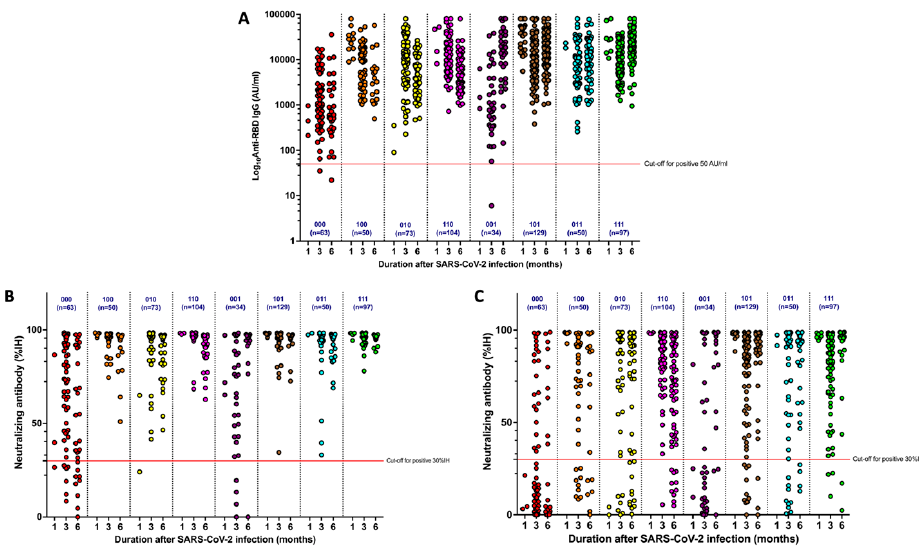
Figure 3. Dynamic changes of antibody responses for various regimens of COVID-19 vaccine (n,